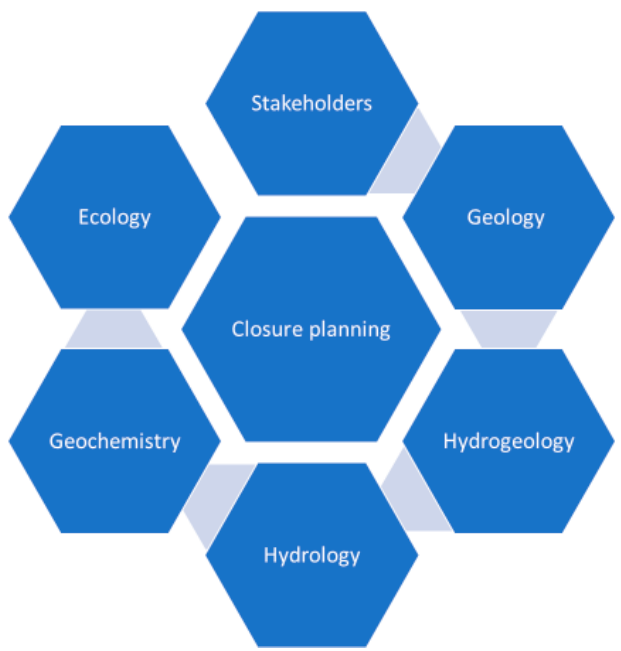
Figure 10. A transdisciplinary approach to opportunity planning of pit lakes.